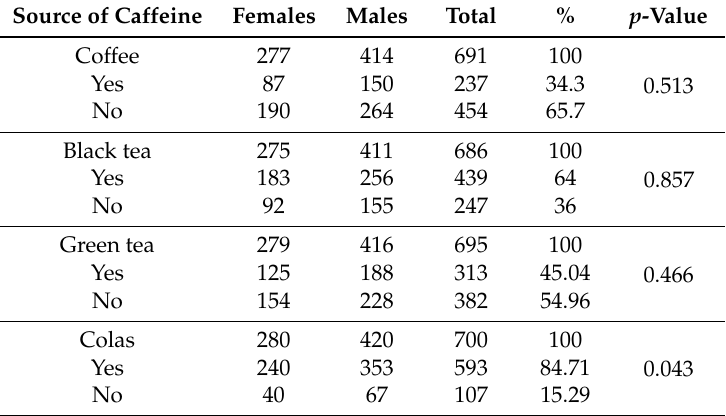
Table 7. Consumption of sources of caffeine other than